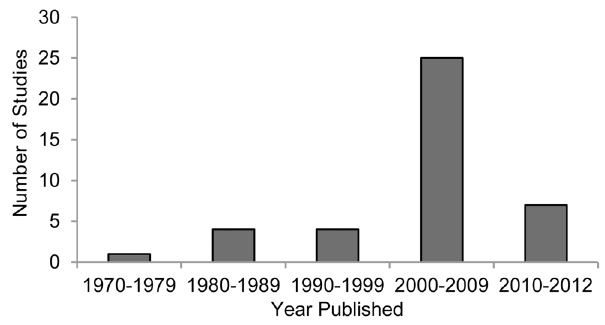
Figure 3. Publications by decade. The number of studies (n=41) published by decade, investigating the impacts of winter recreation on fauna from 1970 to mid-2012.